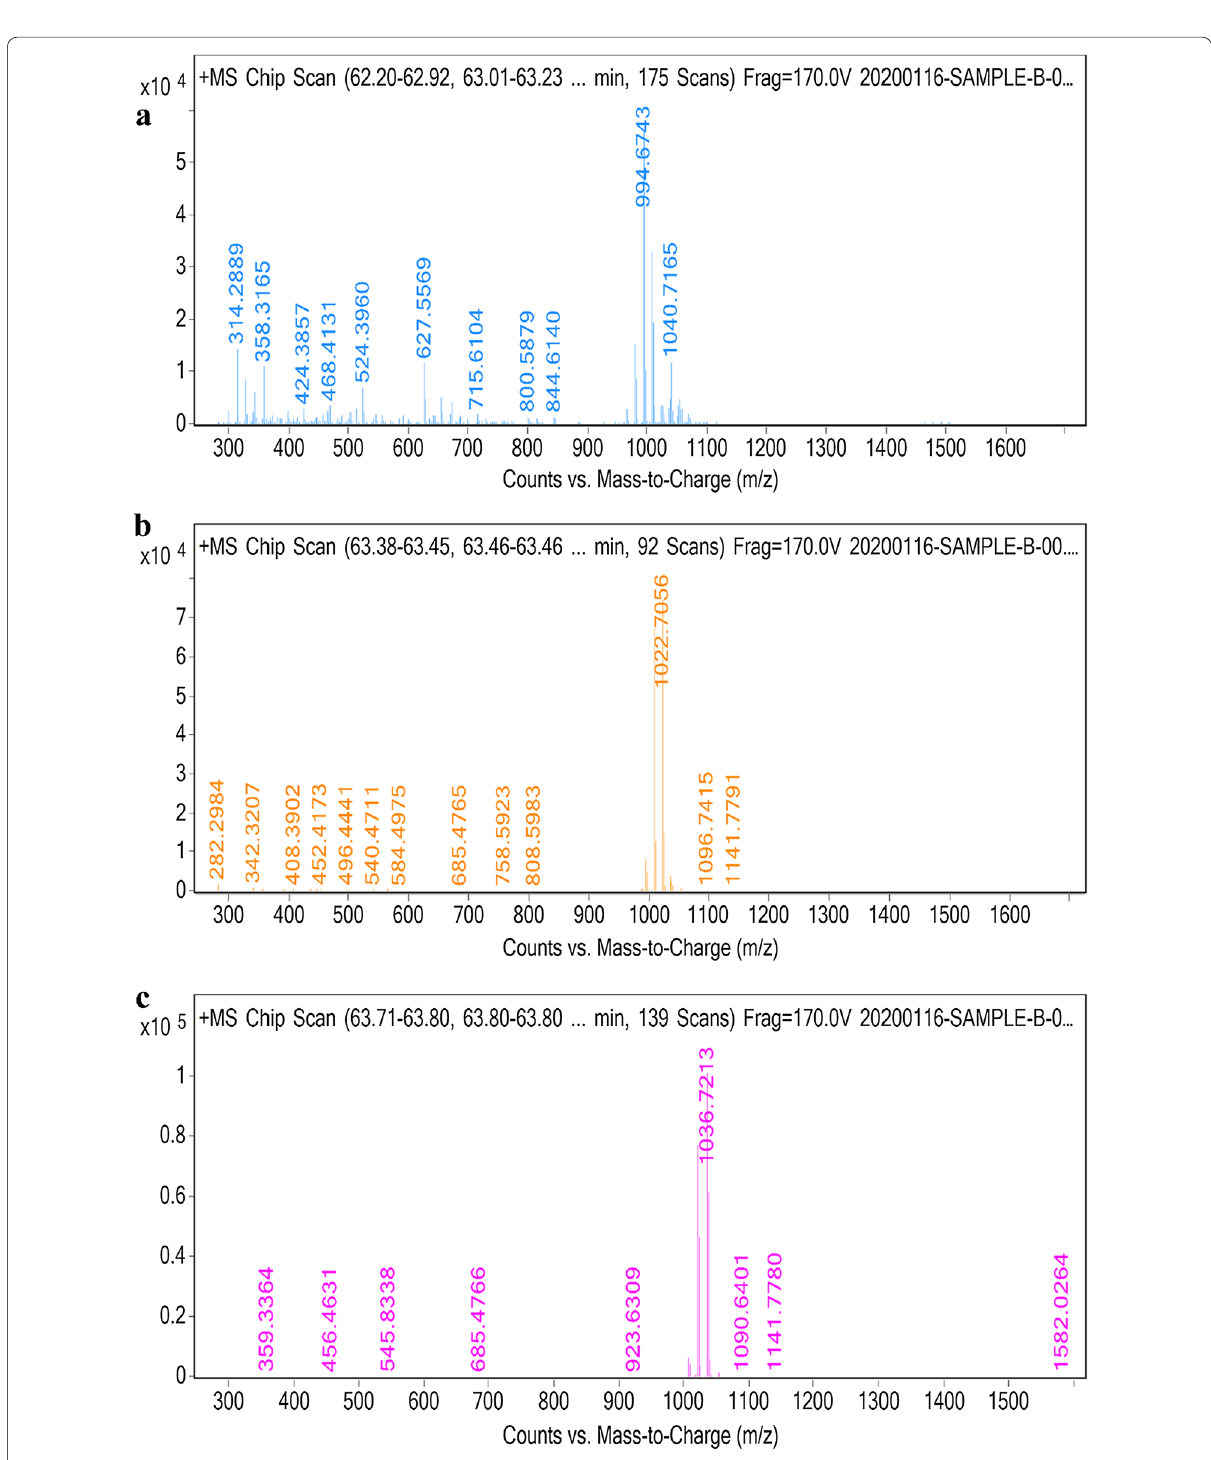
Fig. 7 Full ESI–MS scan of LC separated peak from dual gradient fraction (F5 80% acetone pH8) in positive ion mode showing molecular ion [M of peaks at range of 62 to 64 min a C 12 -Surfactin b C 14 -Surfactin c C 15